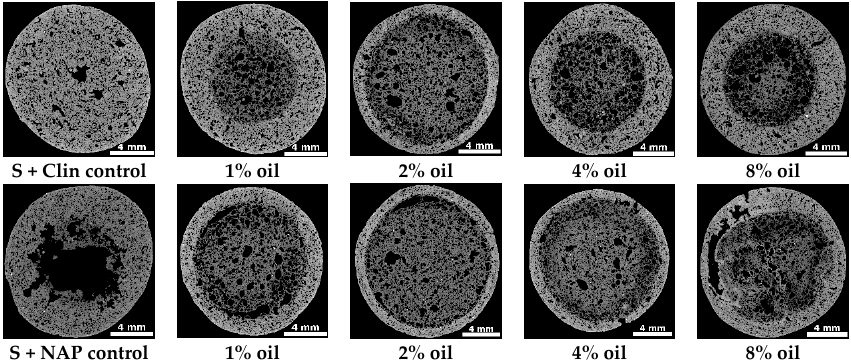
Figure 4. Exemplary 2D cross-section images derived from microtomography for the studied materials. Black areas are pores, white areas are solid.